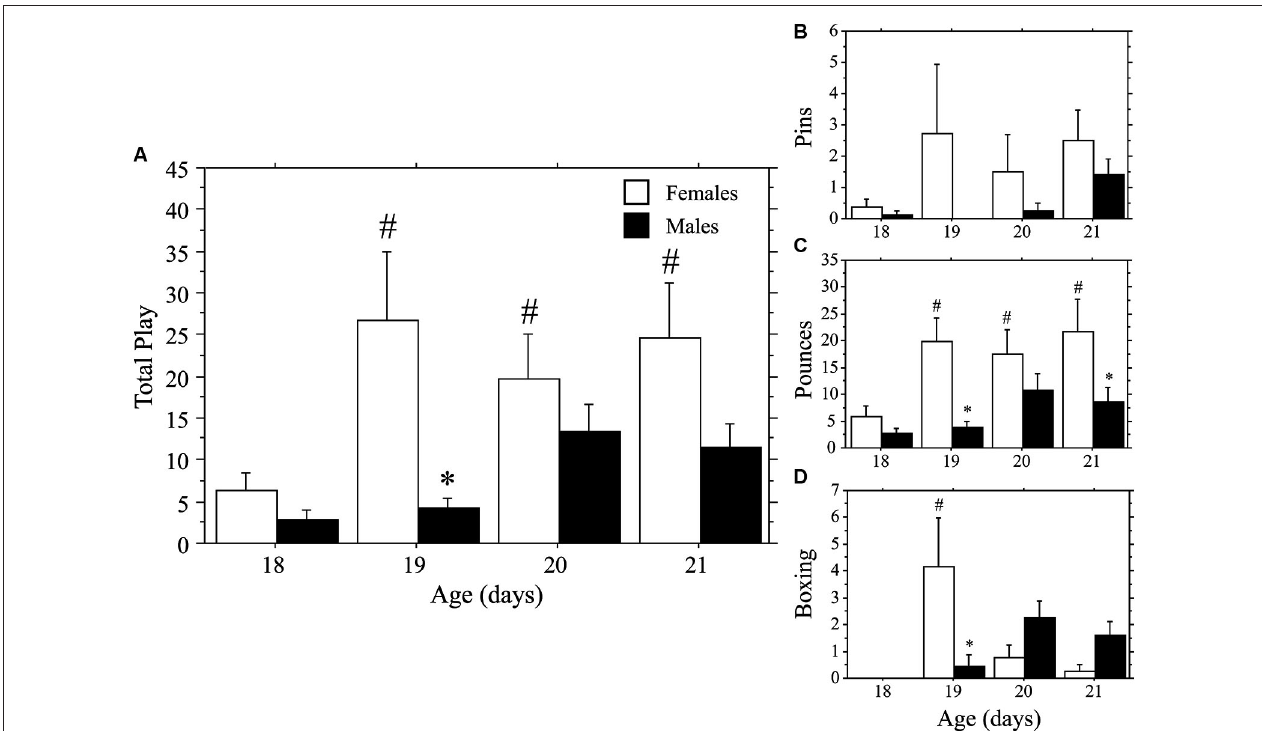
paired with 35-day-old juvenile play partners; * indicates significant sex difference within age group; # indicates significant increase above day 18 baseline measure for